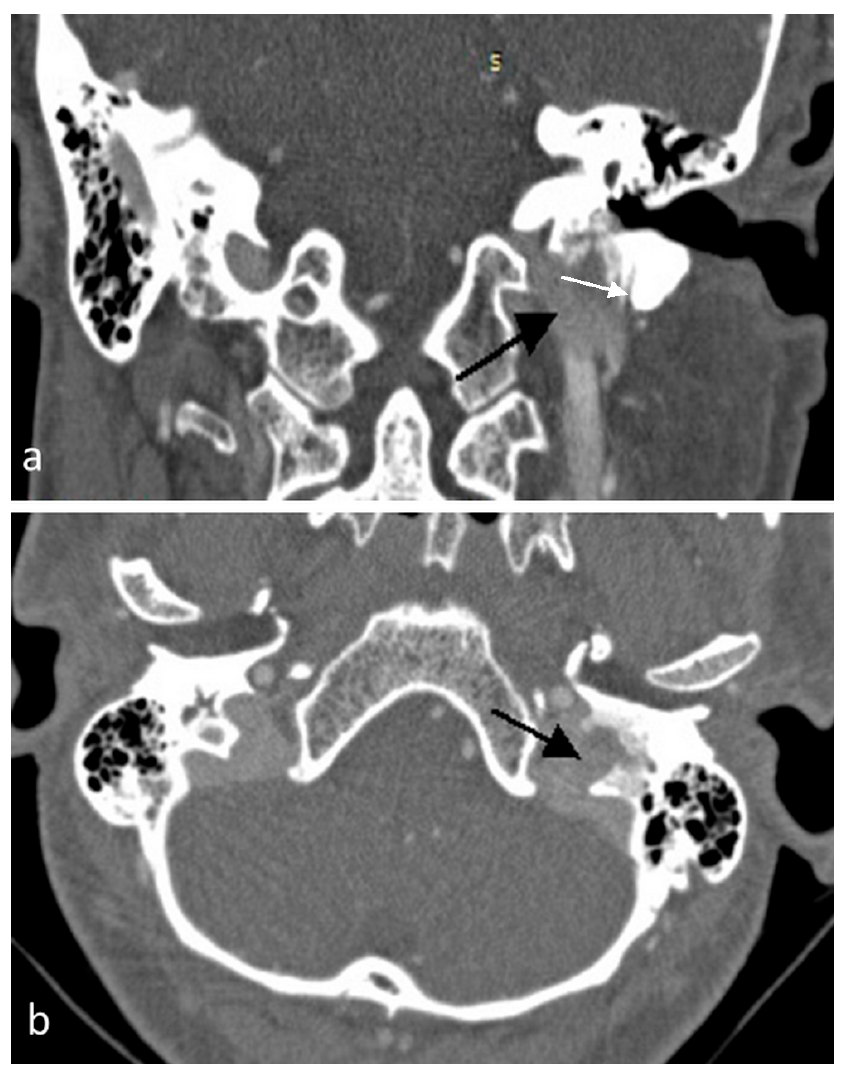
Figure 1. Computed tomography scan of temporal bone, ( a ) coronal and ( b ) axial views show soft tissue mass destructing the jugular foramen (black arrow). White arrow indicates stylomastoid foramen.